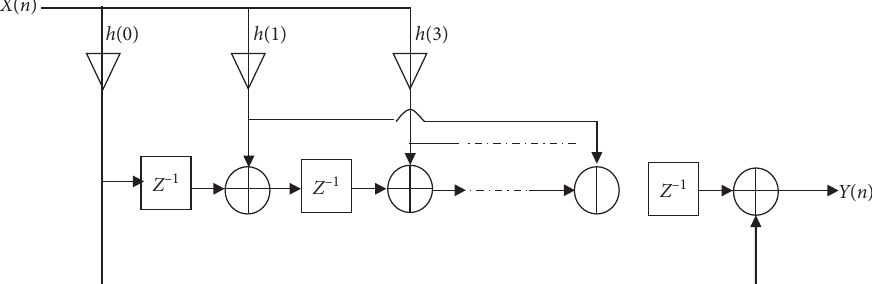
Figure 4: The transposed symmetric structure of a linear-phase FIR filter ( M